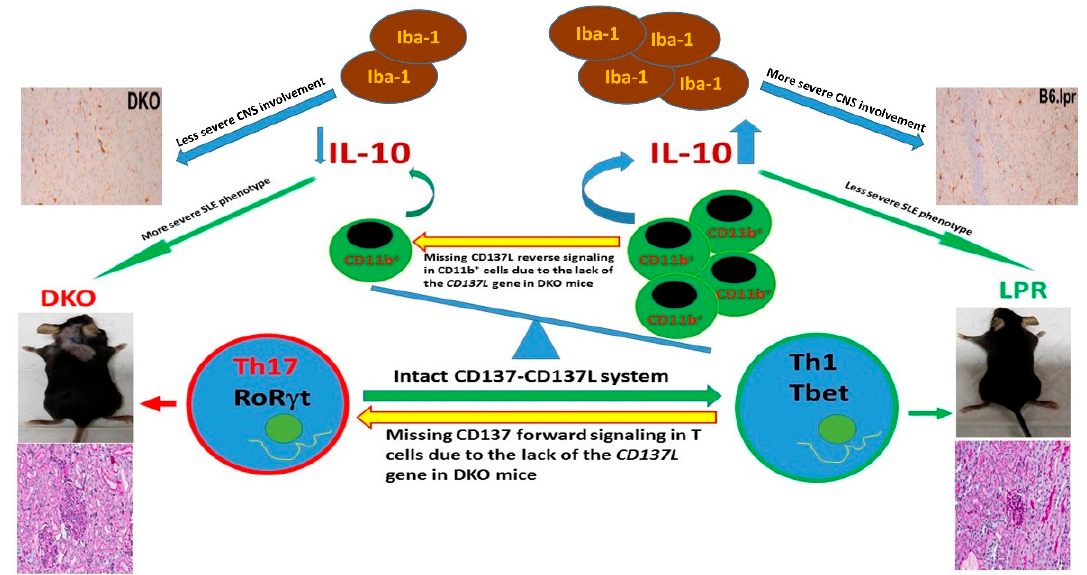
Figure 2. A diagram depicting the potential mechanisms related to the more severe SLE phenotype in the double knock out (DKO) mice than in B6.lpr mice. Interruption of the CD137-CD137L system by knocking out the CD137L gene in the DKO mice leads to a higher proportion of splenic Th17 cells as a result of missing CD137 forward signalling. A lower proportion of CD11b + cells which produce IL-10 is likely due to missing CD137L reverse signalling, and a lower serum IL-10 level in the DKO mice is likely the result of a lower proportion of CD11b + cells in the DKO mice, accompanied by a lower tendency to express IL-10. These three factors potentially promote the more severe SLE phenotype in the DKO than in the B6.lpr mice. Less activated lba-1 + microglia, on the contrary, leads to less severe pathology in the central nervous